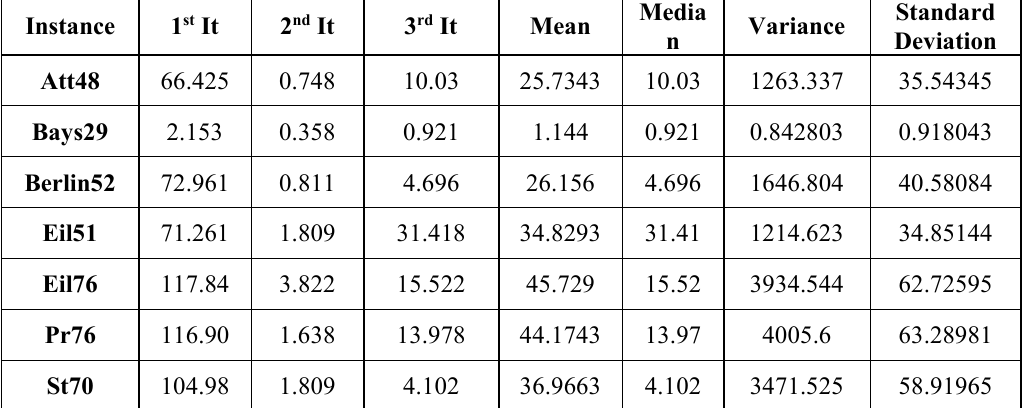
Table 2. Calculation of Mean, Median, Variance and Standard Deviation Based on time for